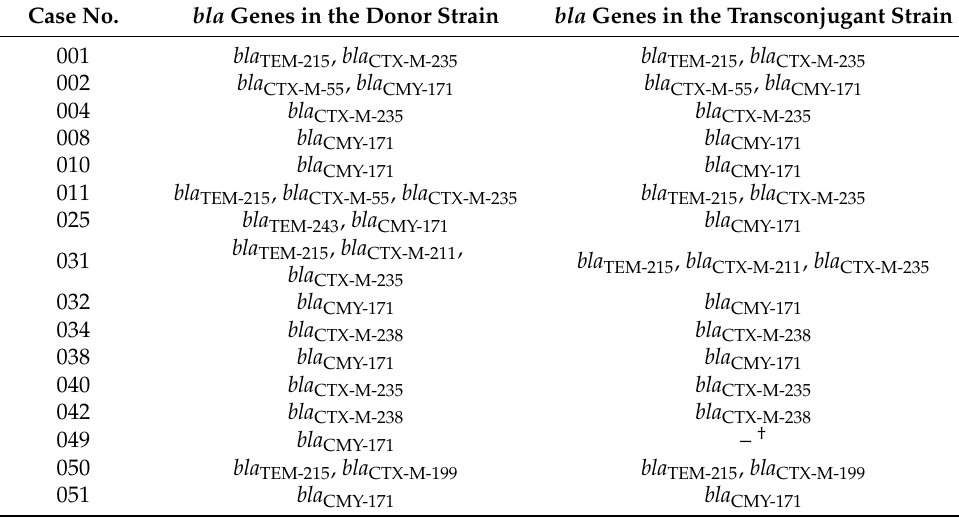
Table 2. PCR detection of bla gene in donor and transconjugant strains in a conjugation test.